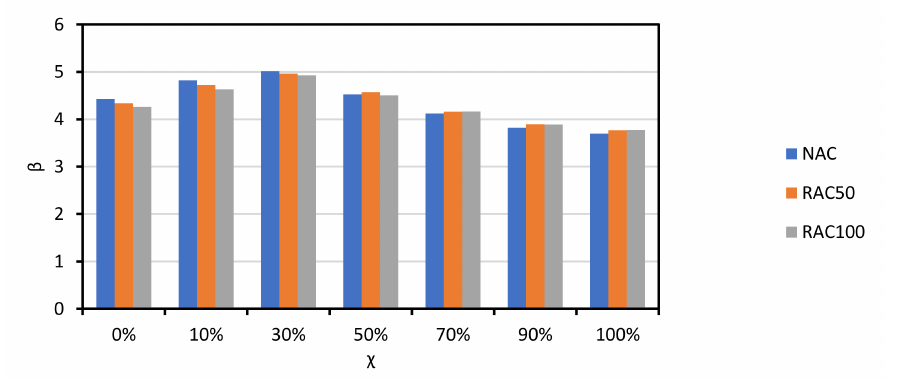
Figure 5. β vs. χ of Slab 1 for NAC and RAC. prEN1992 [32]. γ NAC = 1.40 and γ CRAC 50 = 1.50, γ RAC 100 = 1.60 (after